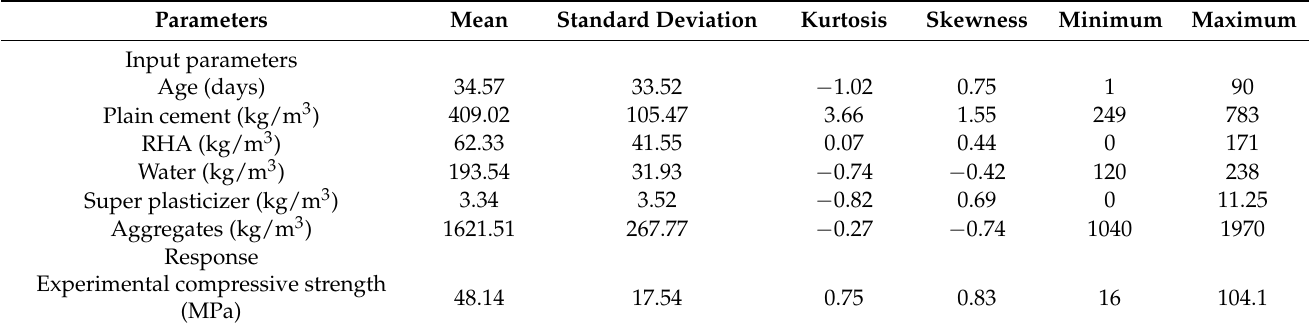
Table 3. Statistical analysis of input